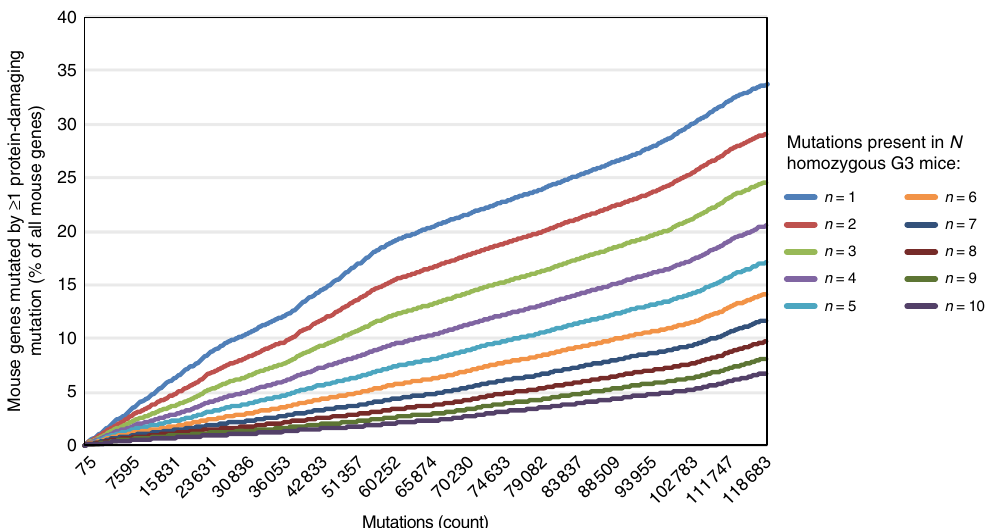
Fig. 4 Genome saturation by 119,452 ENU-induced mutations. The estimated probability of damage for each PP2 mutation class was incorporated into the calculation of genome saturation. Cumulative plot of genome saturation percentage vs. mutation number is shown for each speci fi ed cutoff number of G3 mice carrying truly damaging homozygous mutations. Mutations were non-synonymous coding and potential splicing